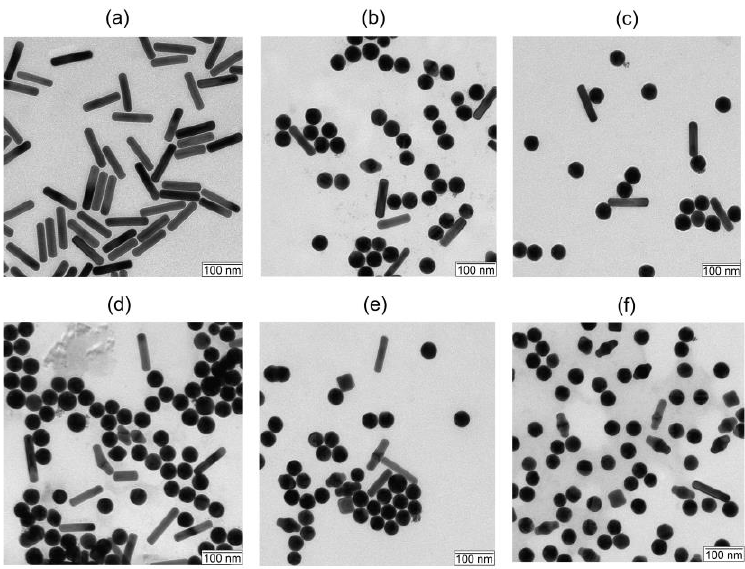
Figure 4. TEM images of gold nanorods before ( a ) and after PM while moving through the capillary at a speed of 15 ( b ), 7.5 ( c ), 3.75 ( d ), 1.88 ( e ), and 0.94 mm/s ( f ), which corresponds to irradiation of 0.73, 1.47, 2.9, 5.9, 11.7 laser pulses, respectively. Scale bars are 100 nm.